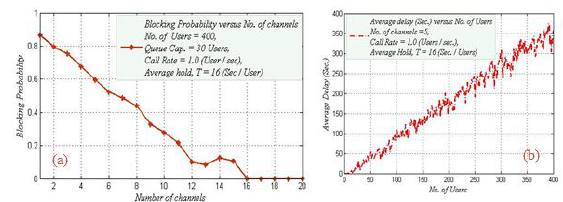
Fig. 10. (a) Time blocking probability versus no. of channels, (b) Average delay in a second versus no. of